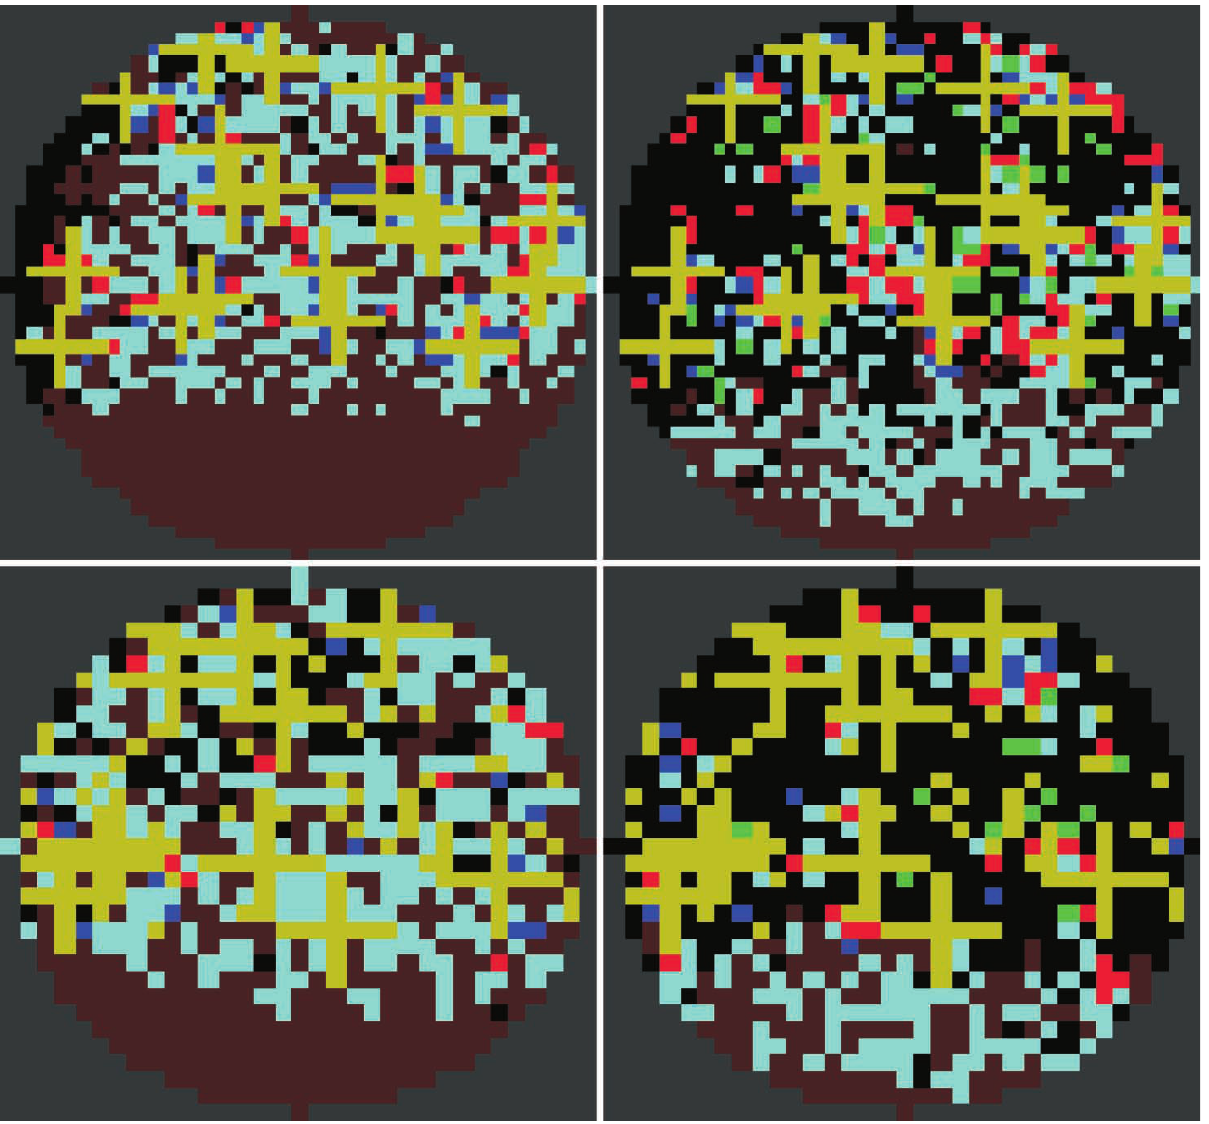
FIGURE 2 Sections through the signaling model GC: a section through the 2D (upper row) and 3D (lower row) simulated GC reaction is shown at days 4 and 8. Centroblasts (dark red) build a dark zone besides the FDC (yellow) network. Centrocytes (cyan, blue) are positively selected (blue) in interaction with FDCs. They further differentiate to plasma or memory cells (green) or recycle back into a re-proliferating cell state, i.e. to recycled centroblasts (light red). The dark zone already present at day 4 is depleted around day